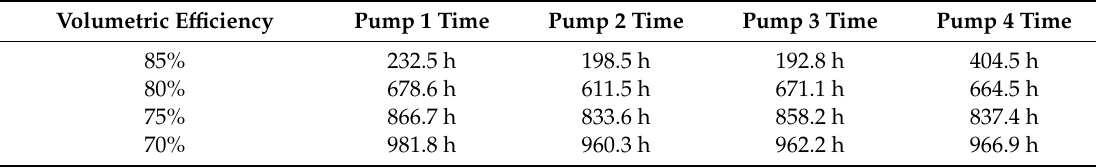
Table 3. Time for sample pump to reach each degradation